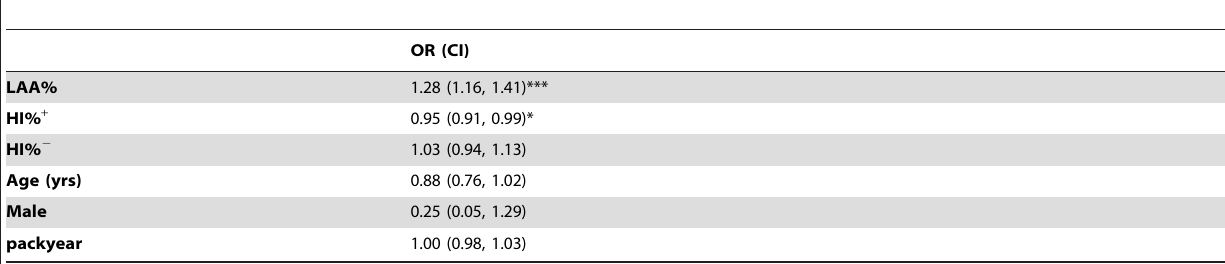
Table 4. Multiple logistic regression model for GOLD classification score among subjects with COPD (n=160).